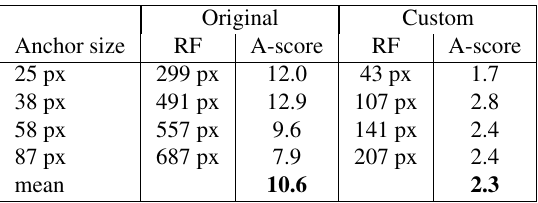
Table 2. Alignment scores (A-score) for original and custom SSD architecture given a dataset-specific anchor sizes